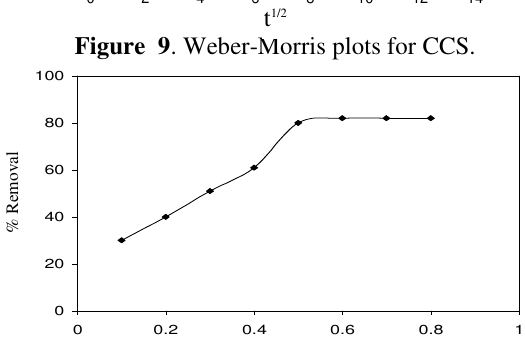
Figure 9 . Weber-Morris plots for CCS.